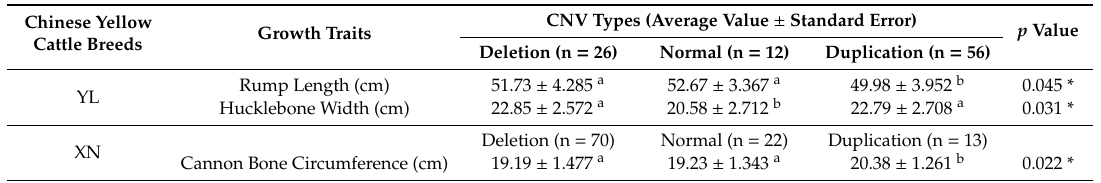
Table 2. Correlation analysis between copy number variation of the MLLT10 gene and Chinese yellow cattle growth